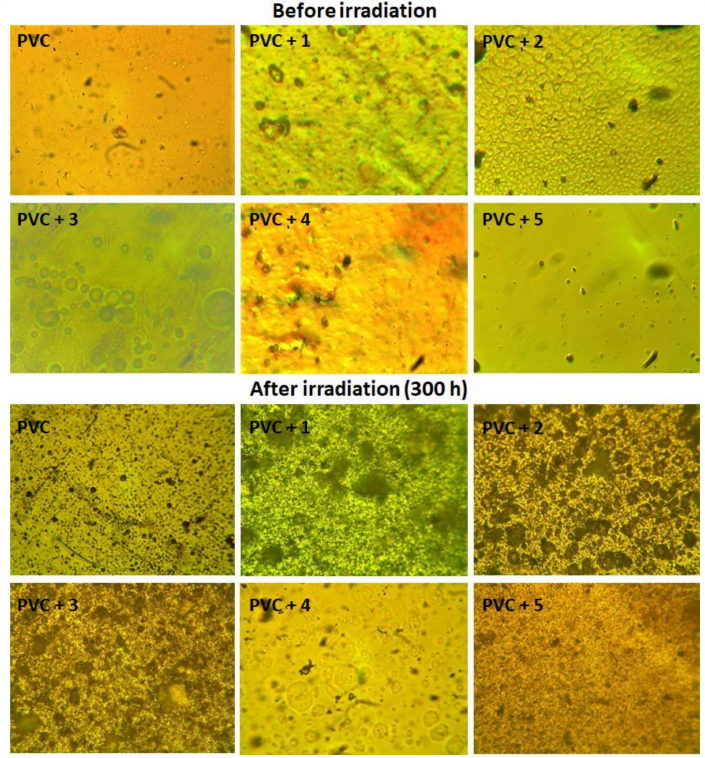
Figure 10. Microscope images (400 × magnification) of